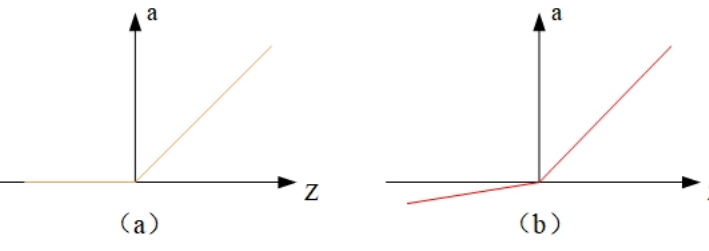
Figure 2. ( a ) ReLU activation functions; ( b ) Leaky ReLU activation functions.